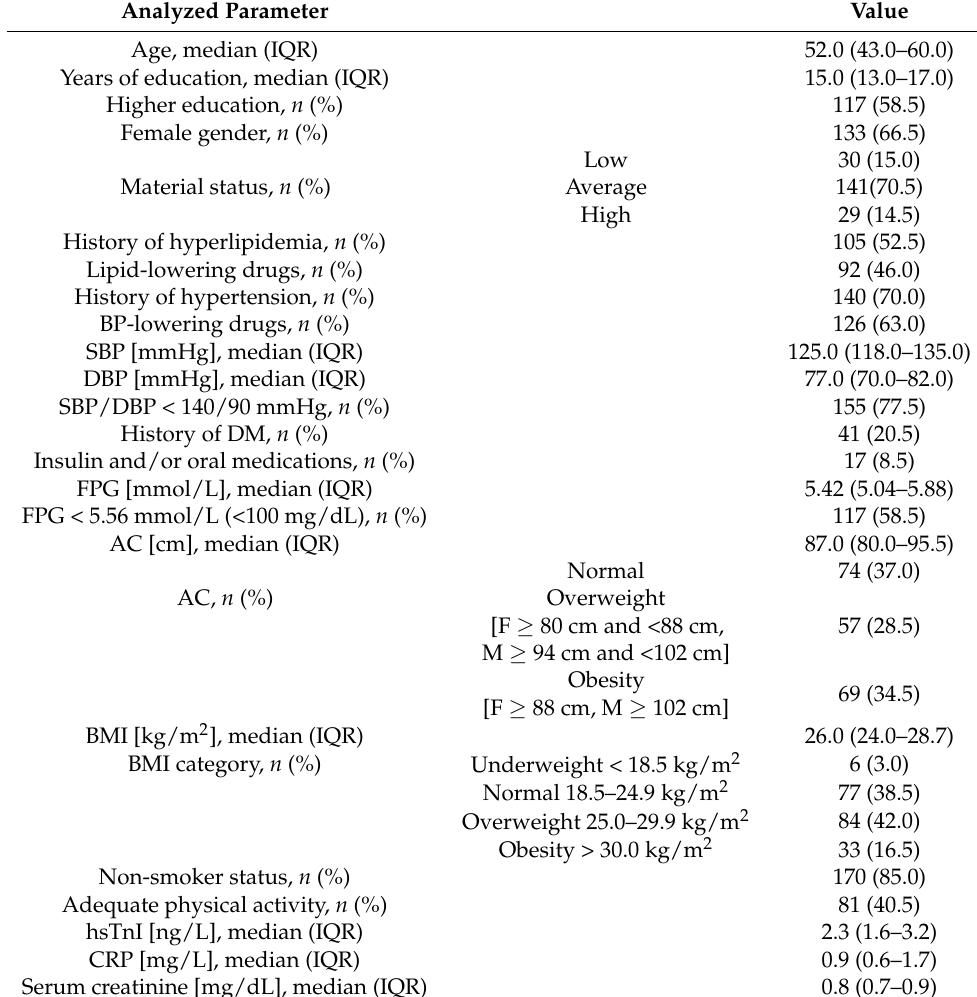
Table 1. Baseline characteristic of the studied group. (AC—abdominal circumference; BMI—body mass index; BP—blood pressure; CRP—C-reactive protein; DBP—diastolic blood pressure; DM— diabetes mellitus; F—females; FPG—fasting plasma glucose; hsTnI—high-sensitivity cardiac